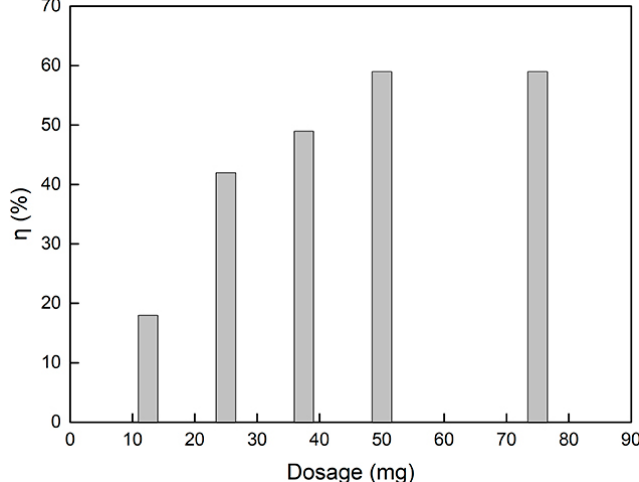
Figure 8. E ff ect of g-C 3 N 4 / Fe 3 O 4 dosage on the catechol removal rate. Figure 8. Effect of g-C 3 N 4 /Fe 3 O 4 dosage on the catechol removal rate. Figure 8. Effect of g-C 3 N 4 /Fe 3 O 4 dosage on the catechol removal rate.